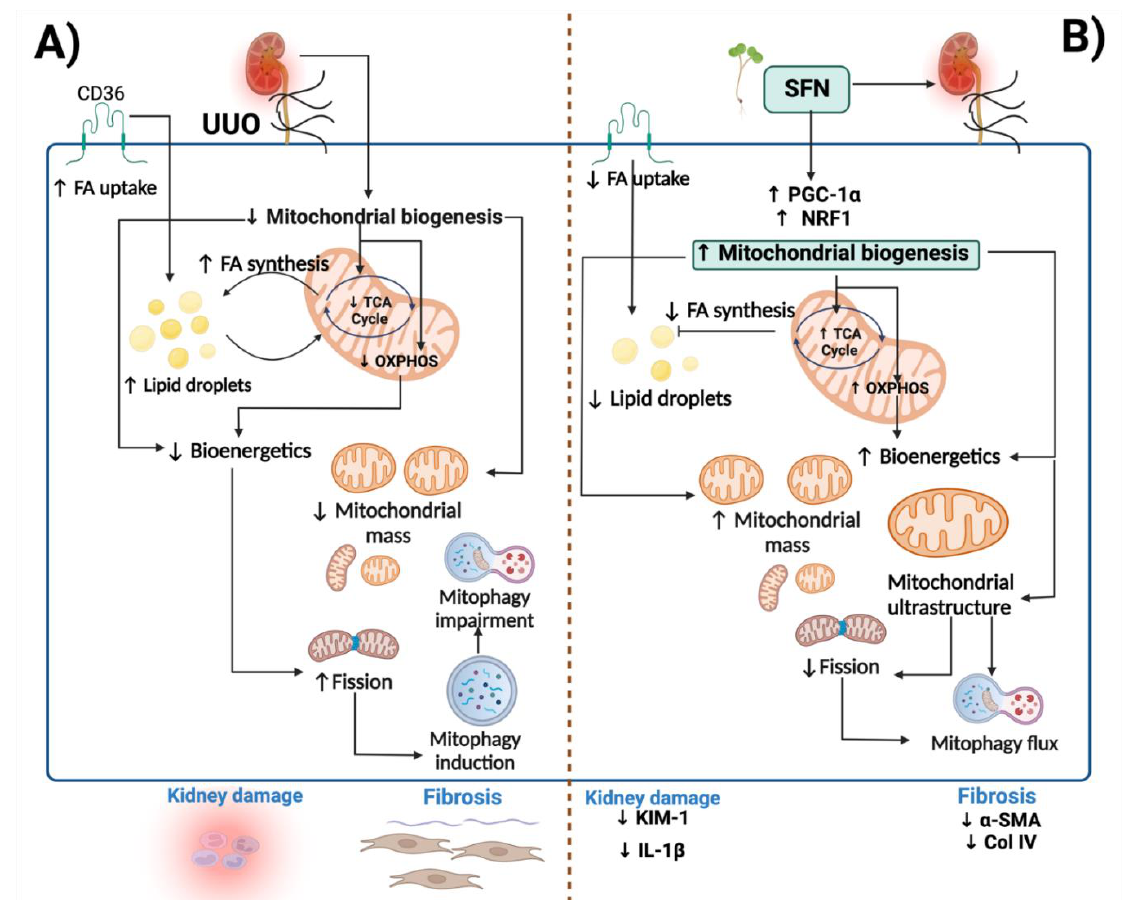
Figure 13. Integrative scheme. ( A ) In the unilateral ureteral obstruction (UUO) model, mitochondrial dysfunction is principally caused by reduced mitochondrial biogenesis, leading to a decrease in mitochondrial mass. Moreover, decreased biogenesis induces bioenergetics impairment, observed by the decline in the TCA cycle and oxidative phosphorylation (OXPHOS). The reduction of the TCA cycle leads to fatty acid (FA) synthesis, causing the formation of lipid droplets, which also can damage the mitochondria. The impairment in bioenergetics induces FA uptake through the CD36 receptor, promoting lipid droplet accumulation. Decreased bioenergetics further induces excessive fission, altering mitochondrial dynamics. Excessive fission activates mitophagy to eliminate damaged mitochondria; however, this process is impaired, leading to the accumulation of